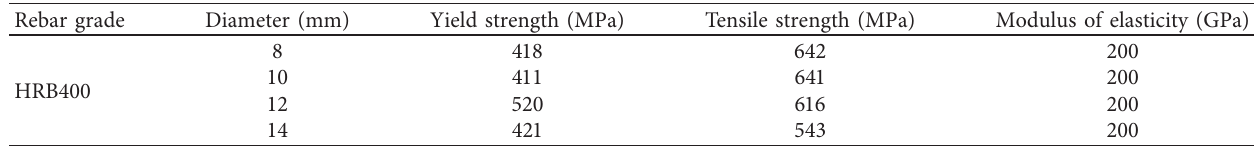
Table 3: Mechanical performance index of steel bar.